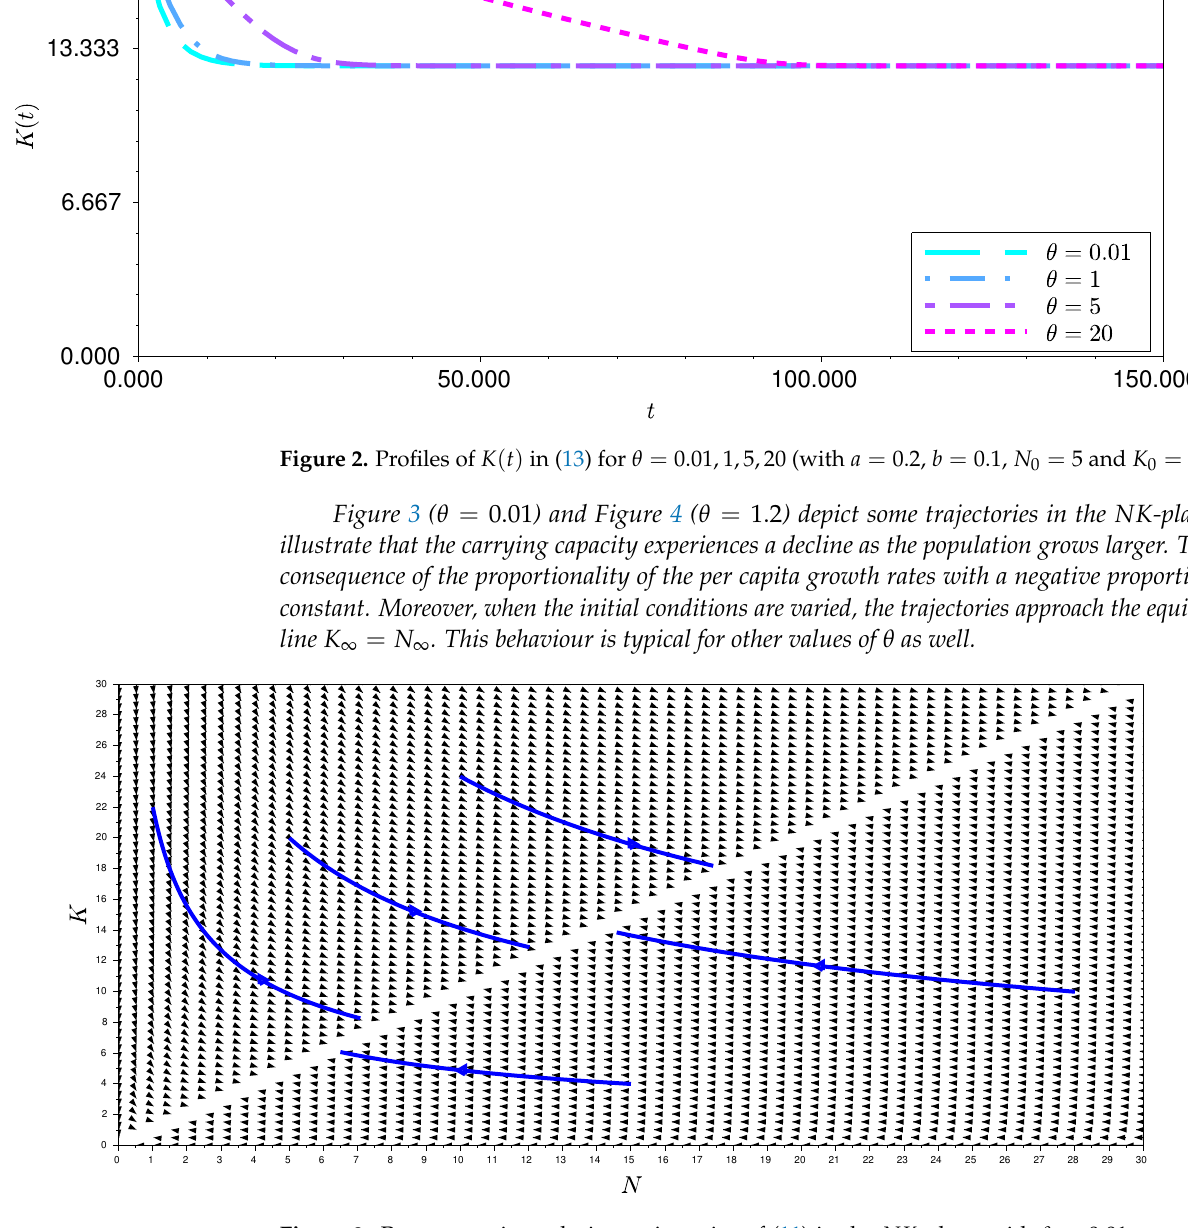
Figure 3. Representative solution trajectories of (11) in the NK -plane with θ = 0.01, a = 0.2 and b =